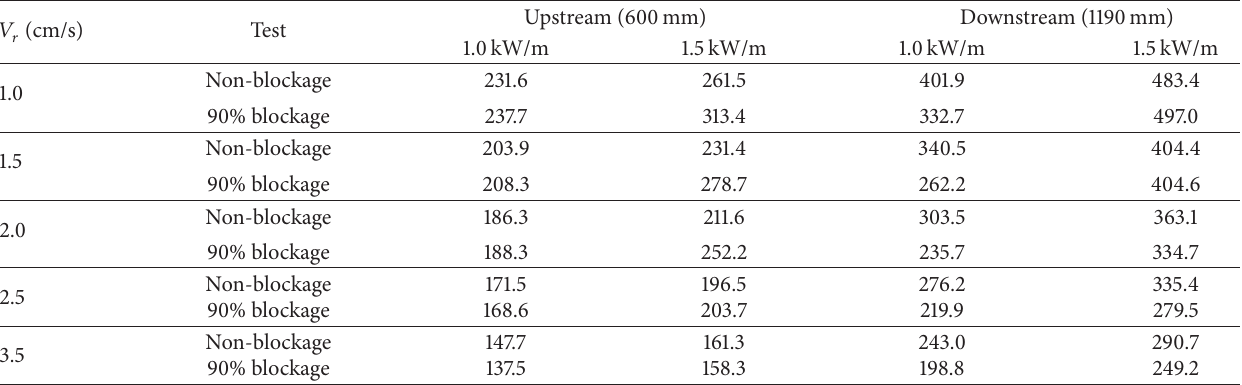
Table 4: Quench time at the upstream and downstream region of